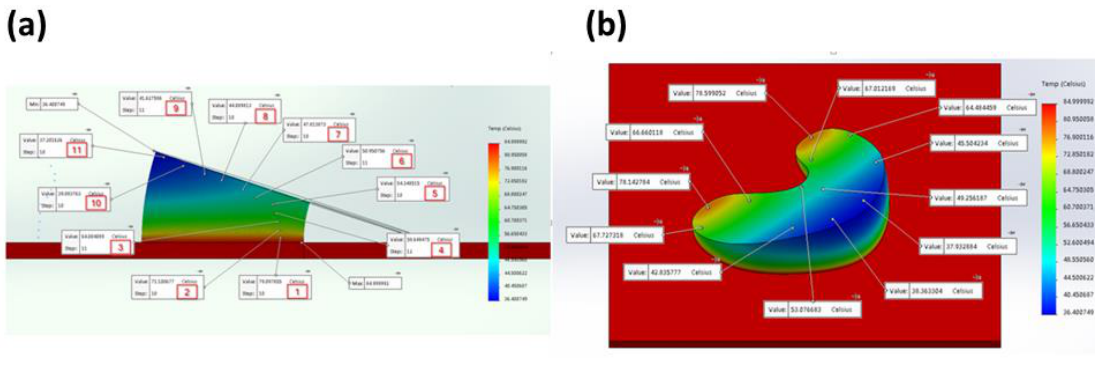
Figure 15. ( a ) Vertical and ( b ) horizontal temperature distribution of on-off layering simulation.